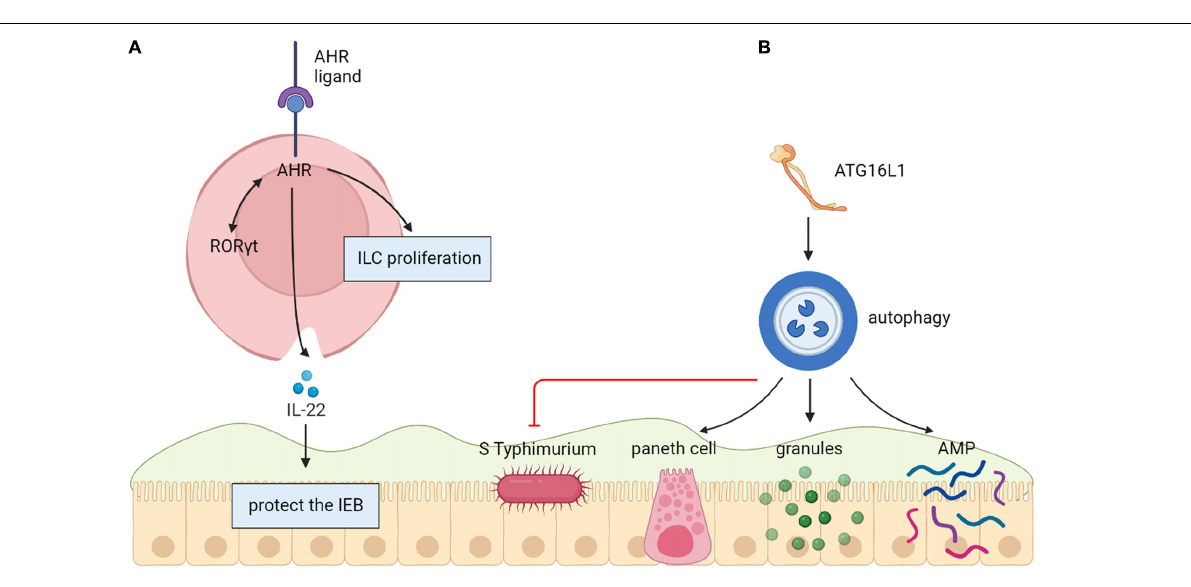
STAT3 Recently, researchers identified a subset of genes specially mediated by STAT3 in answer to leptin, particularly the TRIB1 and inhibitor of cytokine signaling 3 (SOCS3) genes, which